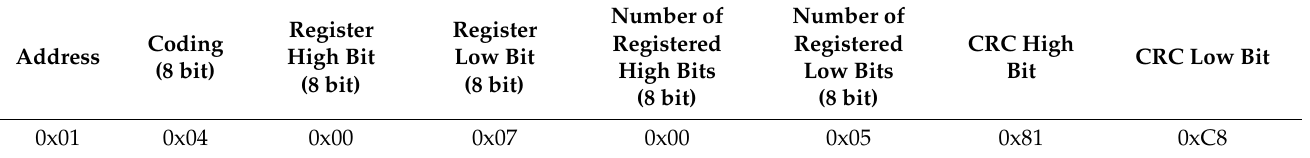
Table A4. The responses format sending from RoLa module to Host (RX64M).